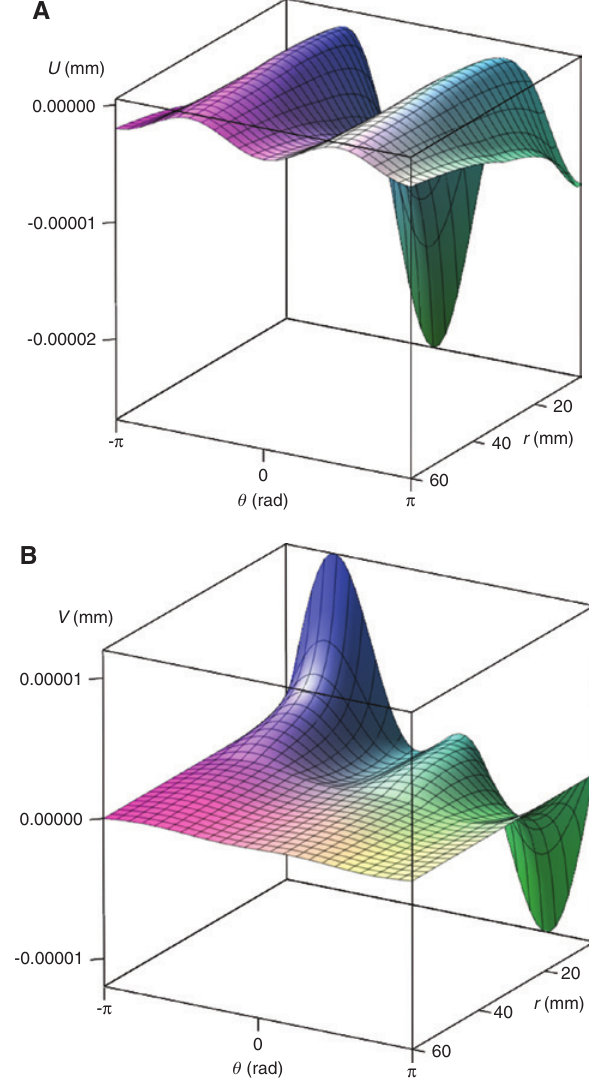
Figure 8: The near-field displacement profiles of the conventional joint under half-cosine loading: (A) radial displacement profile and (B) circumferential displacement